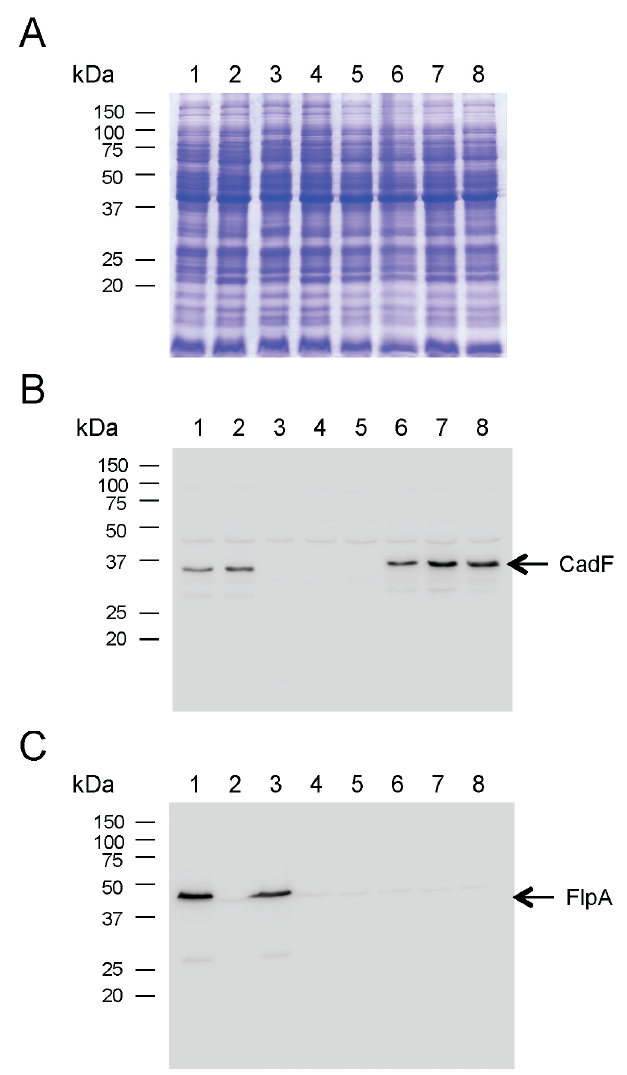
Figure 3. Electrophoretic and immunoblot analysis of C. jejuni Δ cadF Δ flpA transformants. Bacterial whole-cell lysates were separated in SDS 12.5% polyacrylamide gels and either: ( A ) stained with Coomassie Brilliant Blue R-250, ( B ) transferred to polyvinylidene fluoride (PVDF) membranes and probed with a rabbit α -CadF serum, or ( C ) transferred to PVDF membranes and immunoblot with a rabbit α -FlpA serum. The positive control consisted of a C. jejuni wild-type strain. The negative controls consisted of a Δ cadF Δ flpA mutant (lane 4) and the Δ cadF Δ flpA :: cadF NP -FLAG isolate (lane 5). The arrows indicate the CadF protein (Panel B) and the FlpA protein (Panel C). Lanes: C. jejuni strains (1) 81-176 (wild-type); (2) Δ flpA ; (3) Δ cadF ; (4) Δ cadF Δ flpA ; (5) Δ cadF Δ flpA :: cadF NP -FLAG; (6) Δ cadF Δ flpA :: P cadF -283 bp cadF -FLAG; (7) Δ cadF Δ flpA :: P cadF -334 bp cadF -FLAG; and (8) Δ cadF Δ flpA :: P cadF -400 bp cadF -FLAG. Molecular mass standards (in kDa) are on the